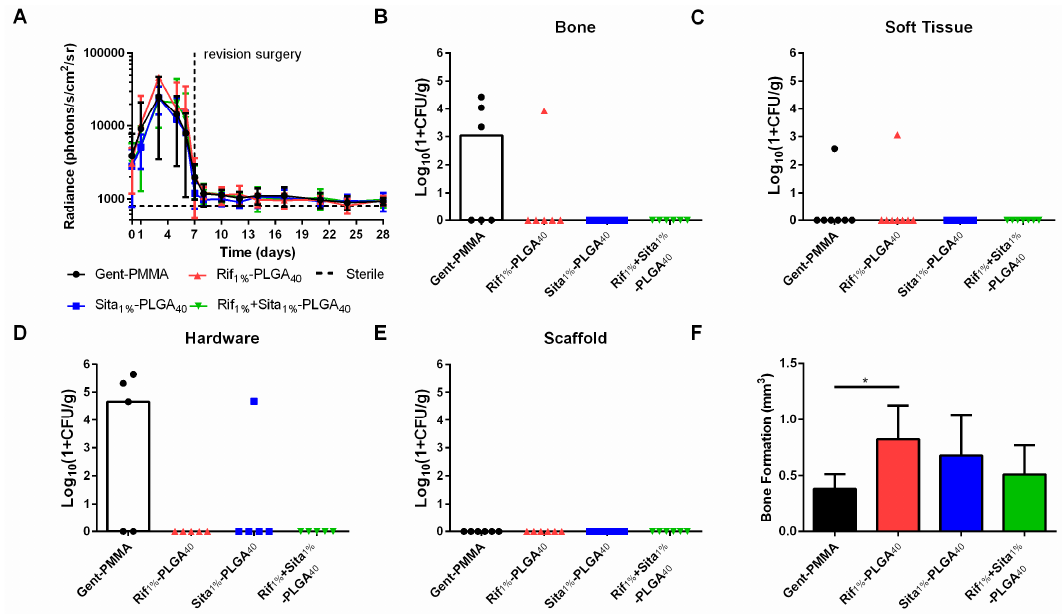
Figure 6. Quantitative assessment of infection management and bone regeneration 10 weeks post-revision surgery for 3D-printed rifampin- and sitafloxacin-laden-CaPS in a mouse model of implant-associated osteomyelitis. Implant-associated osteomyelitis yielded no significant differences between any of the four treatment groups regarding infection management; however, a significant increase in bone formation was observed after 10 weeks of healing. ( a ) In vivo longitudinal bioluminescence measurements yielded no differences in bacterial burden between any of the four groups up to 3 weeks post-revision surgery. ( b-e ) This is further illustrated by the quantification of bacterial